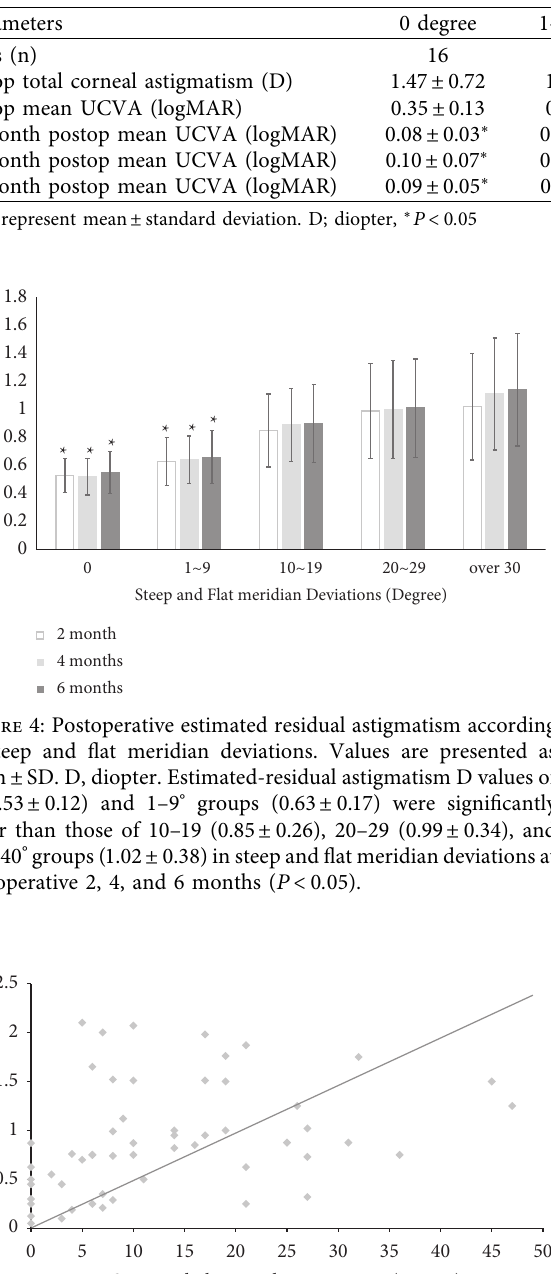
Table 4: Preoperative and postoperative total corneal astigmatism ( D ) and uncorrected visual acuity (UCVA) according to the steep and flat meridian deviation.